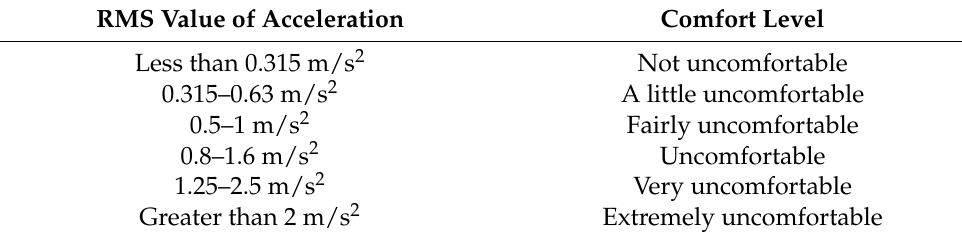
Table 3. Vertical acceleration RMS (root mean square) value and comfort